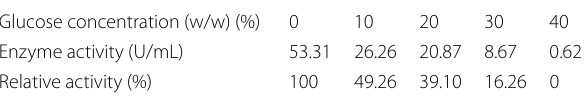
Table 2 Effect of glucose on the activity of purified recom-